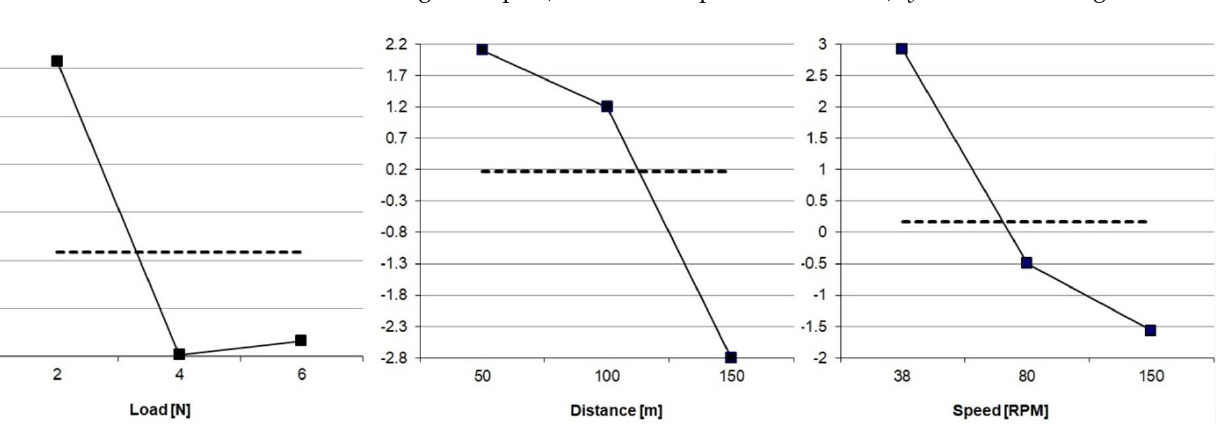
Figure 5. ETA function.